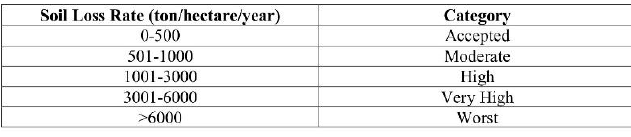
Table 3 : Soil loss rate by DOA [22]